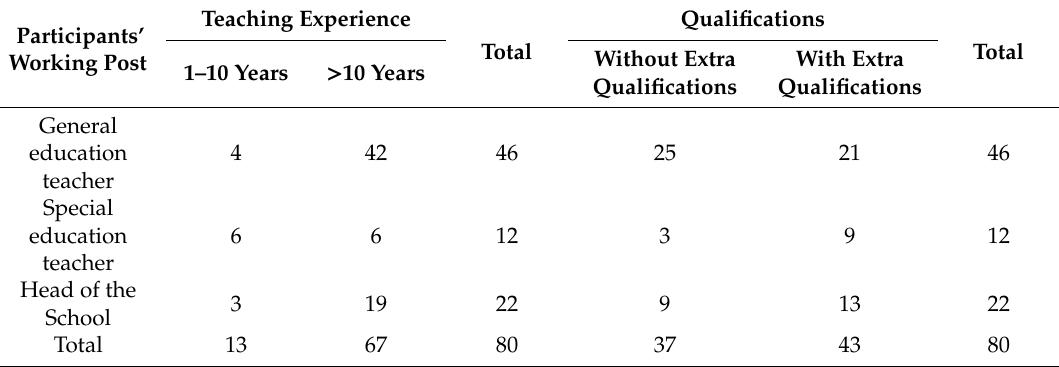
Table 1. The participants of the research according to their working post, teaching experience, and